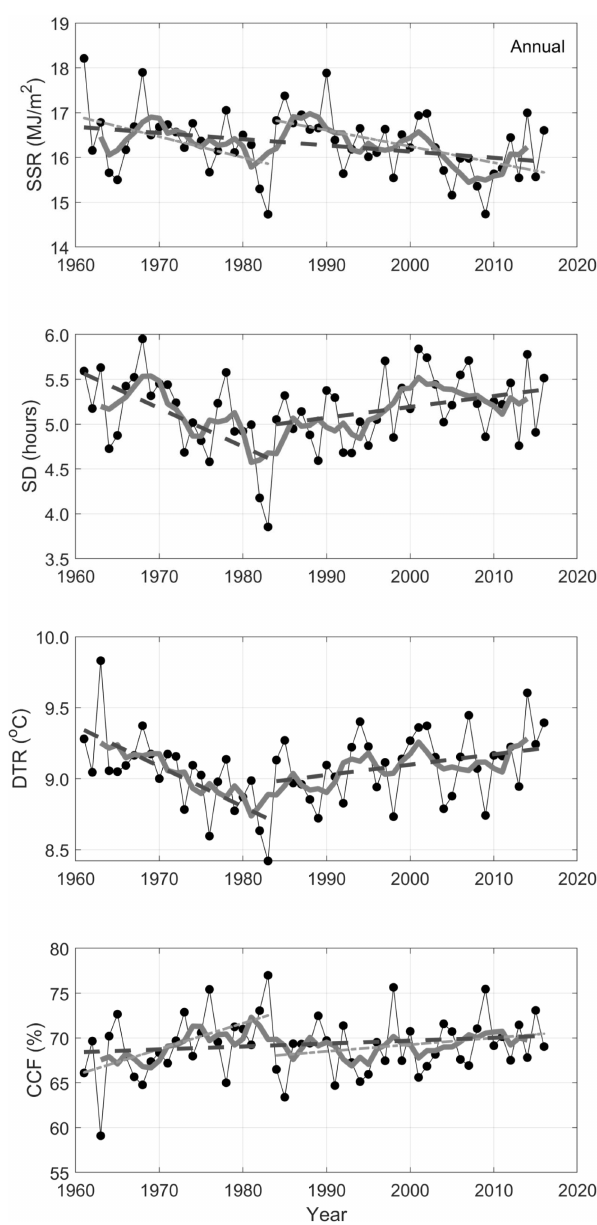
Figure 2. Annual mean variability of surface solar irradiation (SSR), sunshine duration (SD), diurnal temperature range (DTR) and cloud cover fraction (CCF). Grey curves represent 5-year mov- ing averages, and dotted lines are the result of a trend analysis from 1961 to 1983 and from 1984 to 2016. Lines of the trend analysis for SSR and CCF considering all the analysed years, from 1961 to 2016 are also